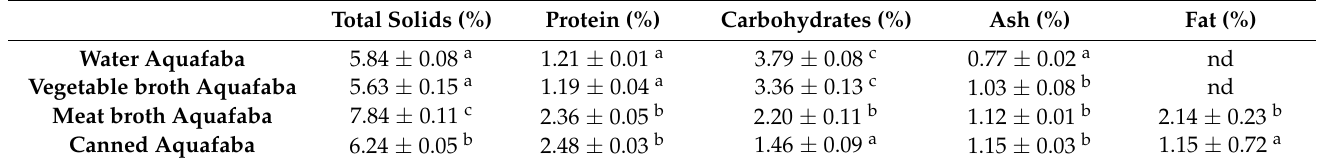
Table 1. Mean values (expressed as g/100 g aquafaba) and standard deviation of the chemical composition of different types of chickpeas